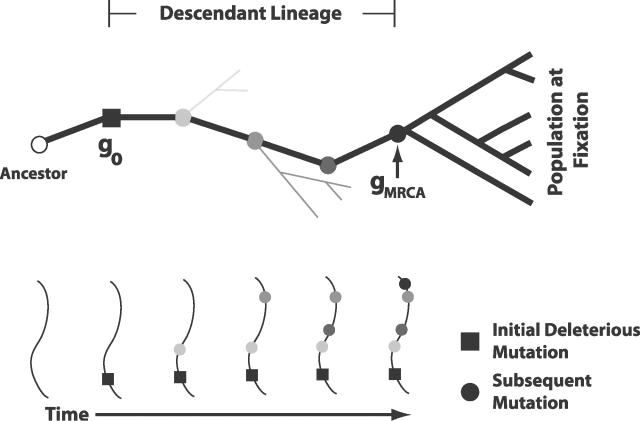
Diagram Depicting a Simplified “Descendant Lineage” for a Genotype Carrying a Deleterious Mutation (Black Square) That Fixed in the PopulationThe genealogy of the population present at fixation is used to determine the MRCA. The descendant lineage is the single genotypic line of descent from the initial mutant genotype to gMRCA. The faint gray branches along the descendant lineage represent lineages that go extinct. The bottom half of this figure shows the accumulation of mutations in the genotypes comprising the descendant lineage.